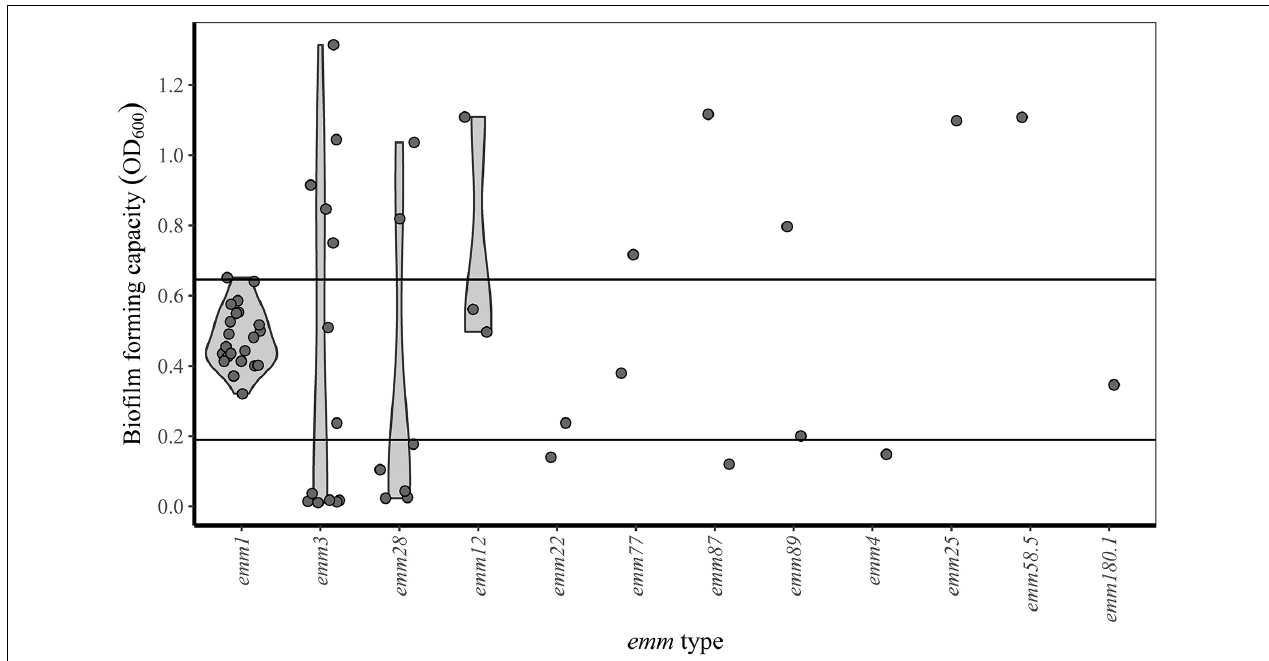
FIGURE 3 | emm type and biofilm forming capacity. Horizontal lines indicate the first (OD 600 = 0.19) and third (OD 600 = 0.65) quartiles. Isolates with OD 600 -values below the first quartile, between the first and third quartile and above the third quartile are categorized as poor, intermediate and good biofilm formers, respectively.